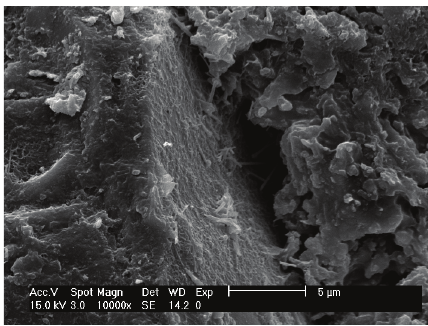
Figure 8: Interface of aged asphalt mastic and cement asphalt